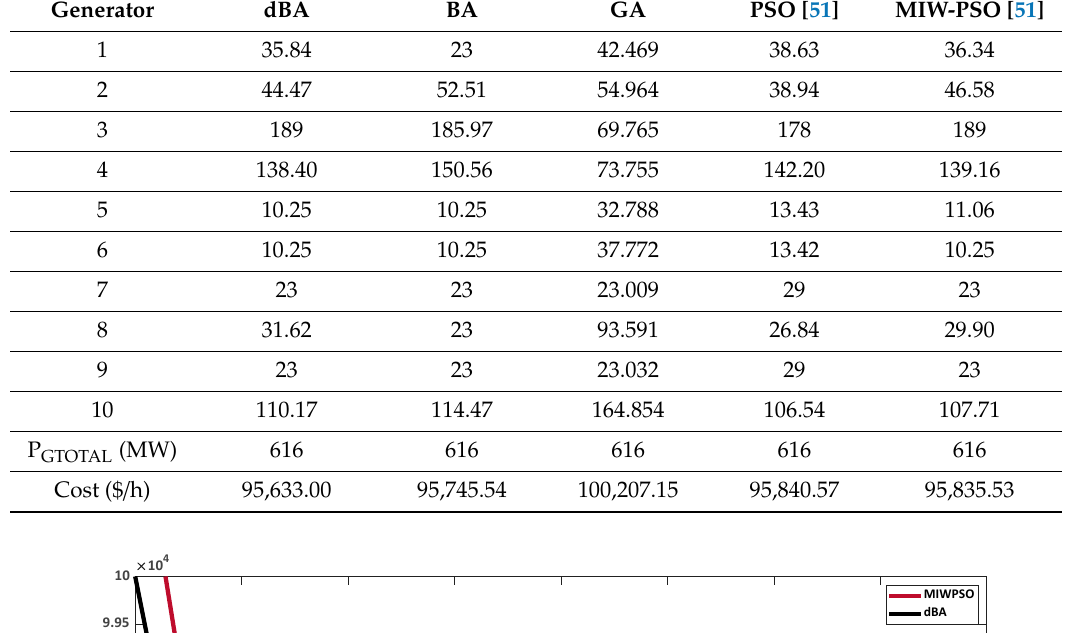
Table 22. Comparison of dBA, BA, GA, PSO, and modified inertial weight-based PSO (MIW-SPO). Generator